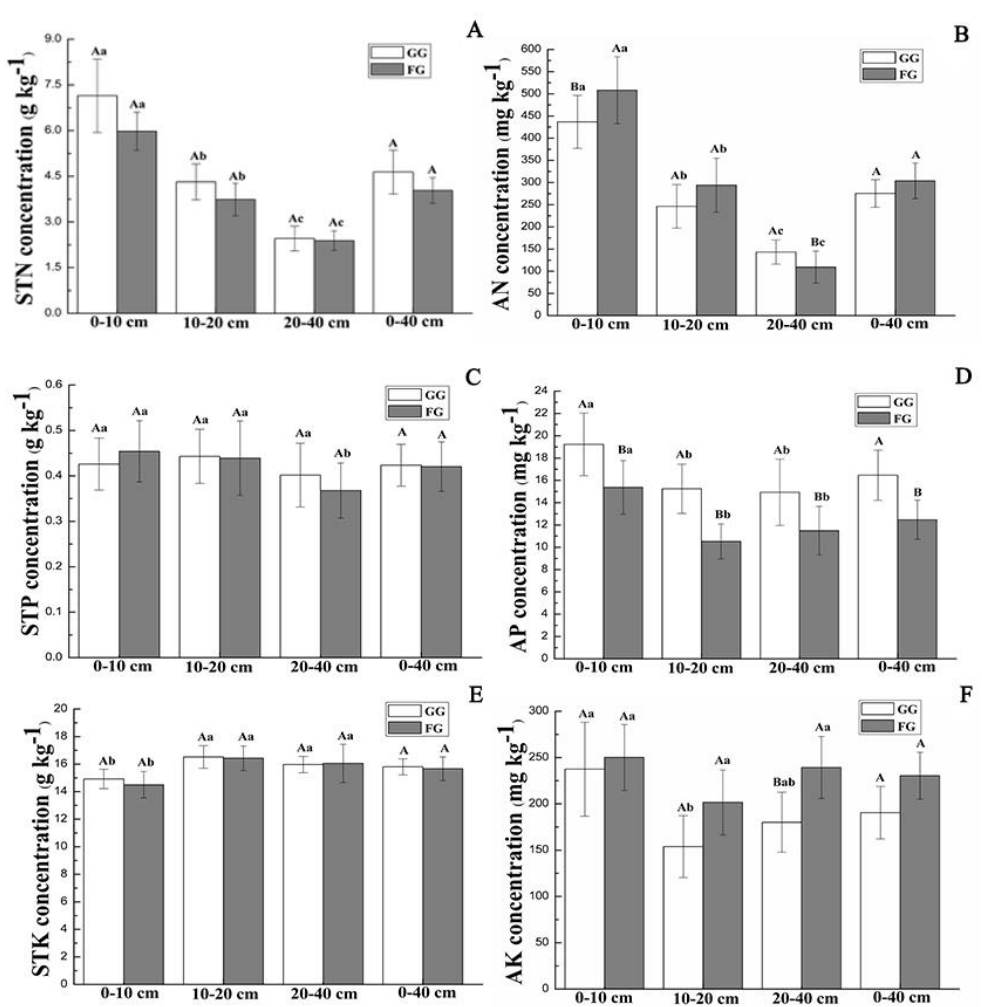
Figure 4. Soil chemical properties under the grazing and fencing treatments in the MM. ( A ): Soil total N concentration; ( B ): Soil available N concentration; ( C ): Soil total P concentration; ( D ): Soil available P concentration; ( E ): Soil total K concentration; ( F ): Soil available K concentration. Values are the means ± standard deviation, the bar charts marked with di ff erent letters on the top of the column (Di ff erent lowercase letters for di ff erent soil layers, and di ff erent capital letters for di ff erent treatments) are significantly di ff erent ( p < 0.05). MM: mountain meadow; GG: grazed grassland; FG: fenced grassland; STN: soil total N; STP: soil total P; STK: soil total K; AN: soil available N; AP: soil available P; and AK: soil available K. The same below. In the TTS, compared to the FG sites, the GG sites had soil total N concentrations with a reduction of 2.58%, 2.90%, 11.77%, and 5.42% in the soil depths of 0 – 10, 10 – 20, 20 – 40, and 0 – 40 cm,